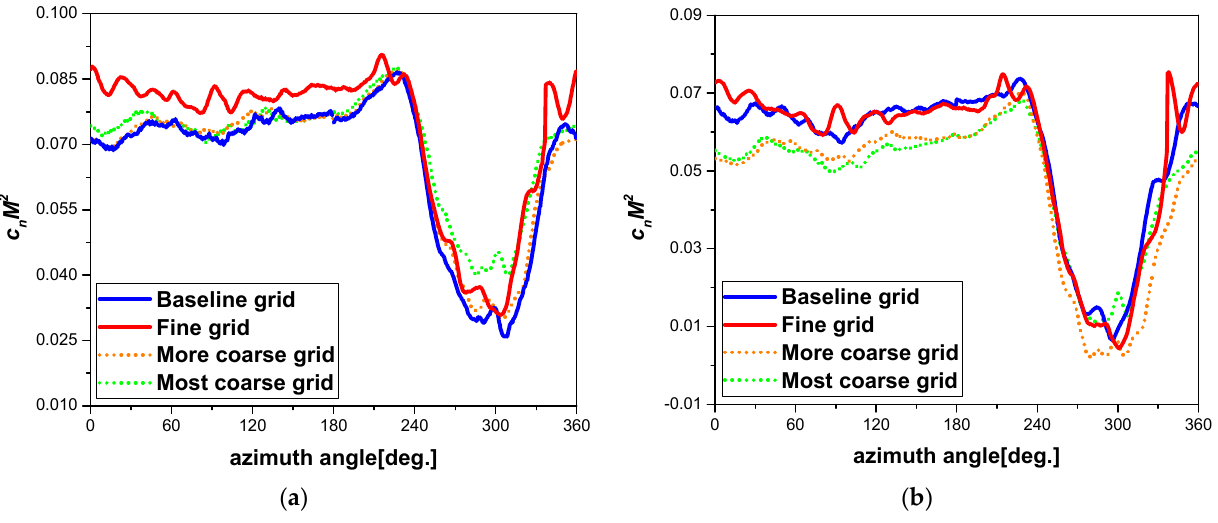
Table 1. The number of grid elements in the various grid systems for hovering height 1R.